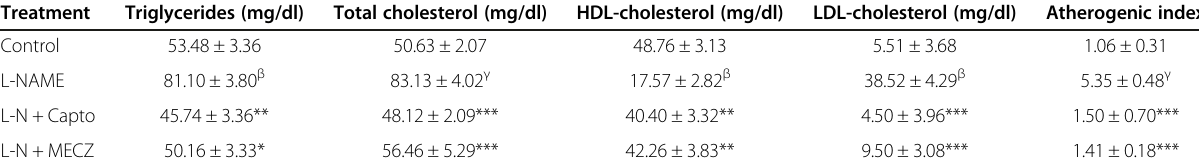
n=5; β p<0.01 and γ p<0.001 significantly different compared to the control; * p<0.05, ** p<0.01 and *** p<0.001 significantly different compared to L-NAME. L- NAME group received only L-NAME 40 mg/kg/day. L-N+Capto received L-NAME plus captopril (20mg/kg/day) while L-N+MECZ received L-NAME plus extract